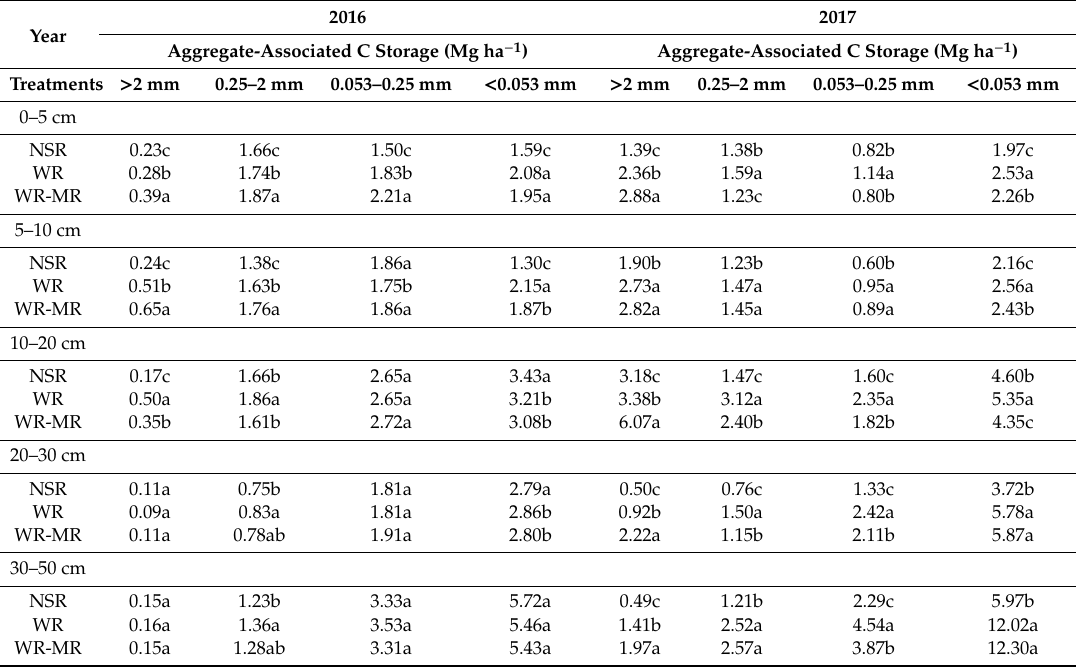
Table 5. E ff ects of straw return modes on aggregate-associated C